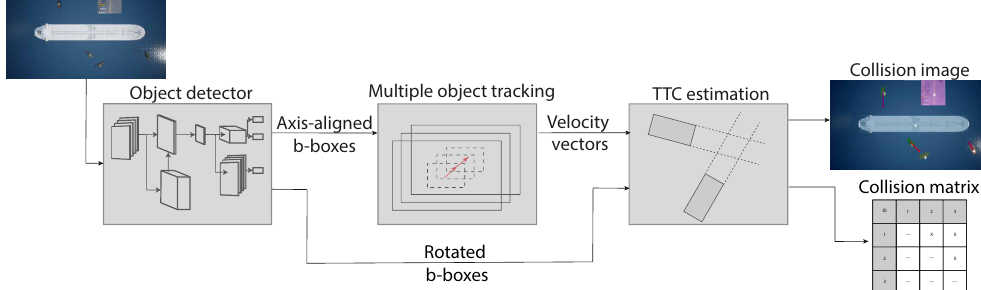
Figure 2. The individual modules that compose our system. The object detection module takes an image as input and outputs bounding boxes and segmentation masks.The second module (object tracker) receives output from object detector and performs tracking of these over time. The third module utilizes output estimated bounding boxes of multiple-object trackers to estimate TTC between all tracked